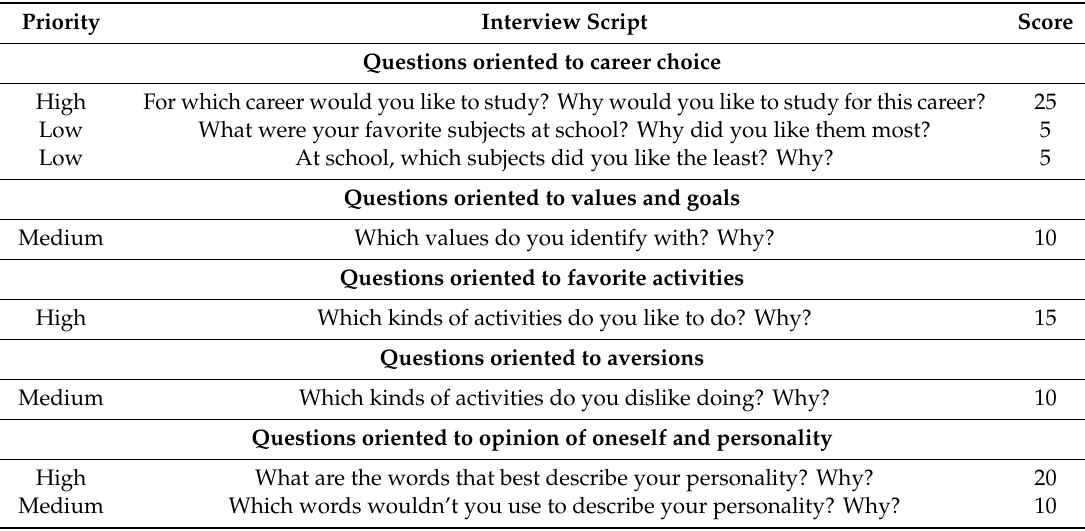
Table 6. The interview